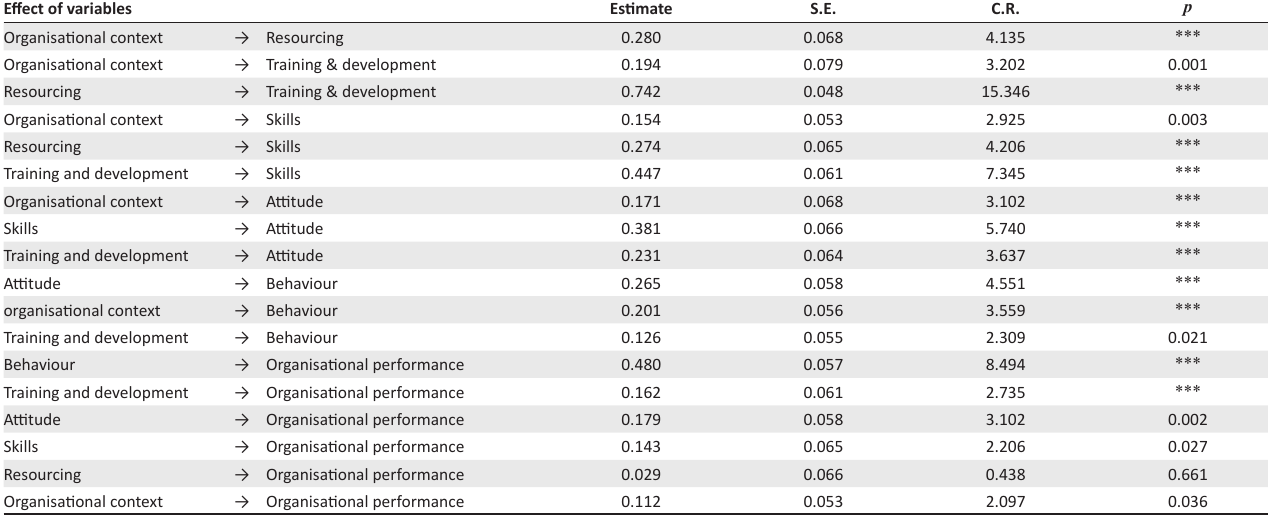
TABLE 5: Hypothesis testing through estimated β value. Effect of